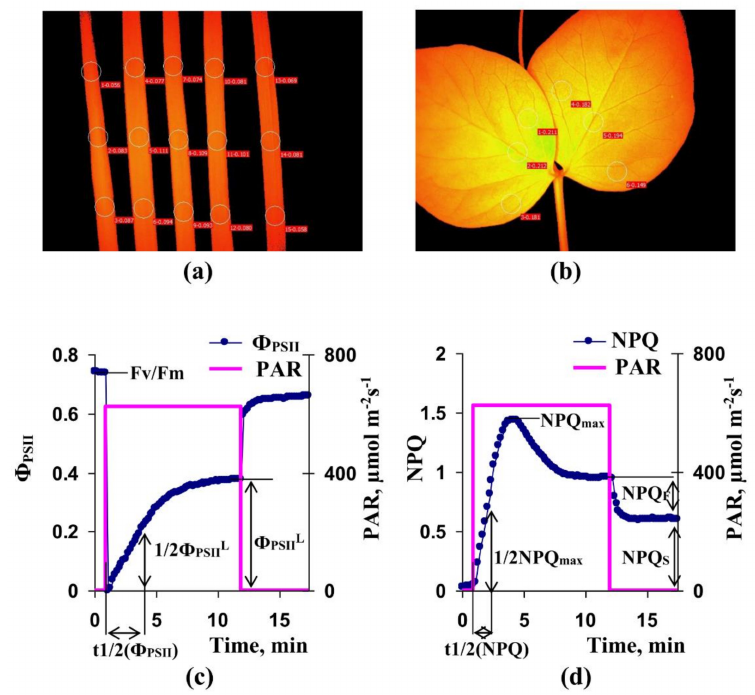
Figure 2. ( a ) Localizations of investigated areas (ROIs) in wheat leaves at PAM-imaging. Photosyn- thetic parameters were averaged for each wheat leaf (3 ROIs were averaged). ( b ) Localizations of investigated areas (ROIs) in pea leaves at PAM-imaging. Photosynthetic parameters were averaged for pea leaf (6 ROIs were averaged). ( c ) Record of changes in quantum yield of photosystem II ( Φ PSII ) under action of actinic light (its intensity is marked as PAR). Fv/Fm is the potential quantum yield of photosystem II, Φ PSIIL is the effective quantum yield of photosystem II after 10 min of illumina- tion by actinic light, and t 1/2 ( Φ PSII ) is the time taken for 50% increase of Φ PSII under illumination. Wheat leaf is used for this record. ( d ) Record of changes in non-photochemical quenching (NPQ) under action of actinic light. NPQ F is fast-relaxing component of NPQ after 10 min of illumination, NPQ S is slow-relaxing component of NPQ after this illumination, NPQ max is maximal value of NPQ, and t 1/2 (NPQ) is time taken for 50% increase of NPQ under illumination. Wheat leaf is used for this